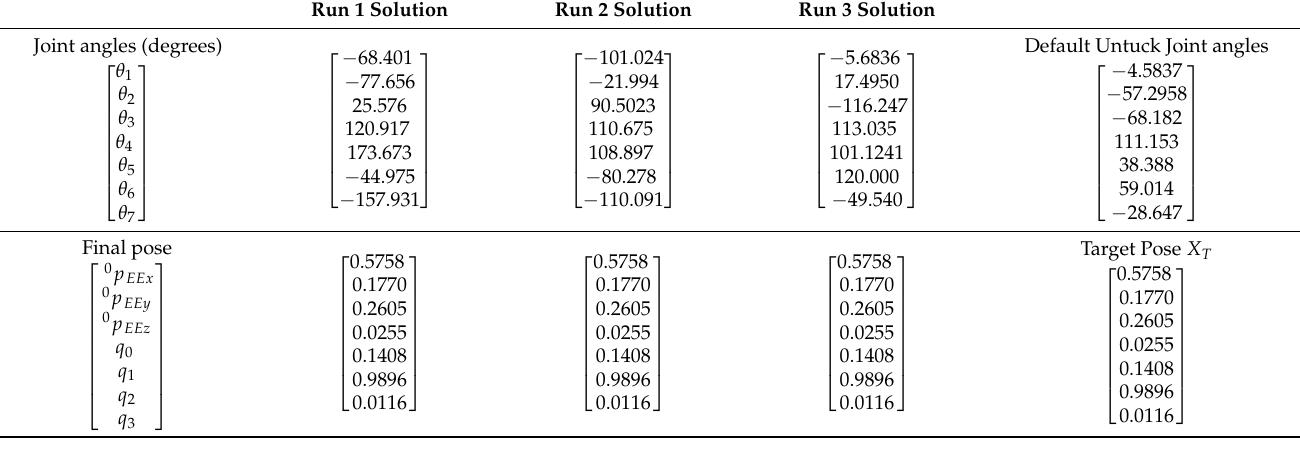
Table 2. Results of three runs with Target Pose at Baxter’s Untuck Con fi guration. Table 2 documents the solution joint angles and corresponding final end-effector pose